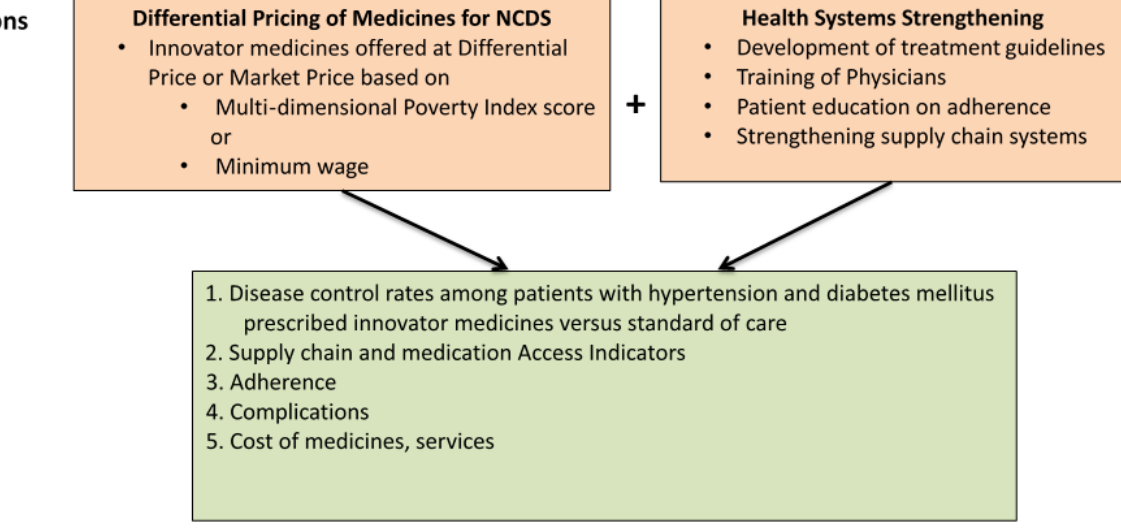
Figure 3. Access and Affordability Initiative conceptual